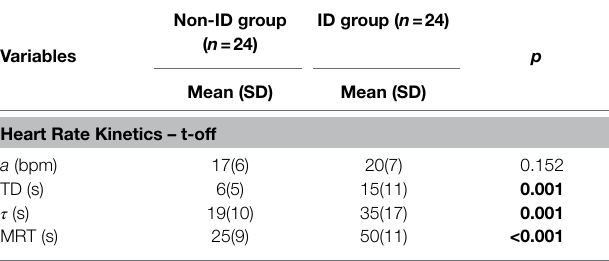
TABLE 3 | Heart rate kinetics during recovery from 6MWT in older adults with and without ID.